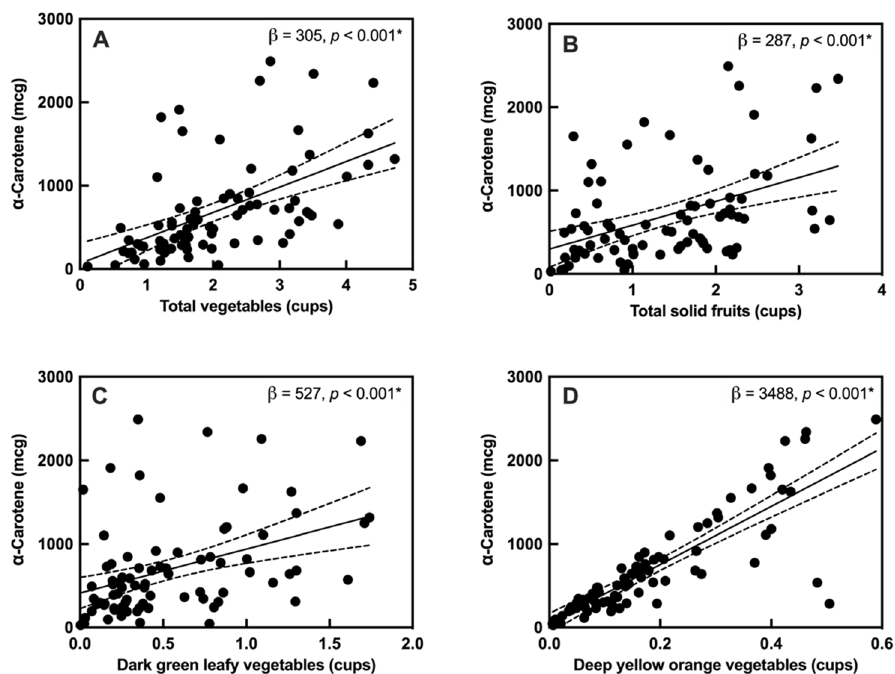
Figure 2. Associations between α -carotene and carotenoid-rich foods: ( A ) total vegetables, ( B ) total fruits (solid), ( C ) dark green leafy vegetables, and ( D ) deep yellow, orange-colored vegetables. “*” indicates a significant correlation with q < 0.05, Solid lines indicate the slope of the association, with 95% confidence intervals indicated with dashed lines.